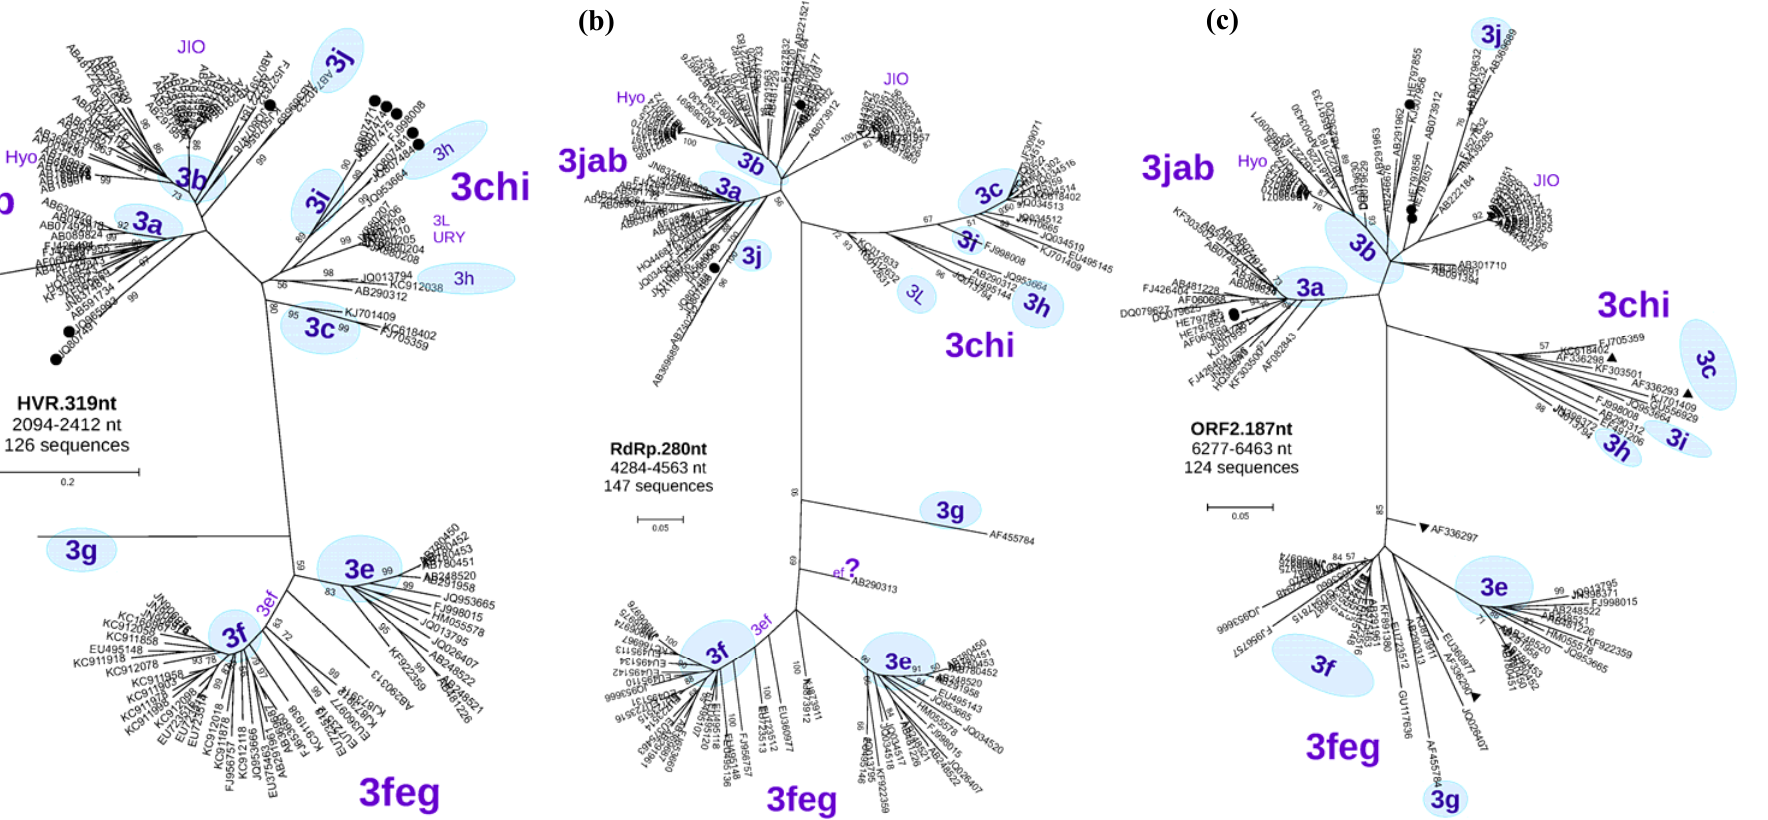
Figure 4. Molecular phylogenetic analysis of: ( a ) HVR.319nt: 126 partial HEV-3 genome sequences spanning the region 2094–2412 nt. The branches for sequences AF455784-3g and JN564006-3a are very large and have been truncated, including eight of the sequences obtained